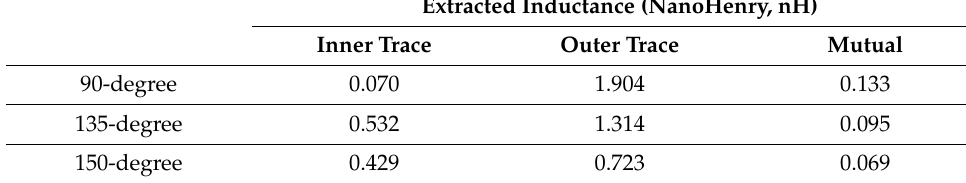
Table 2. Equivalent inductance